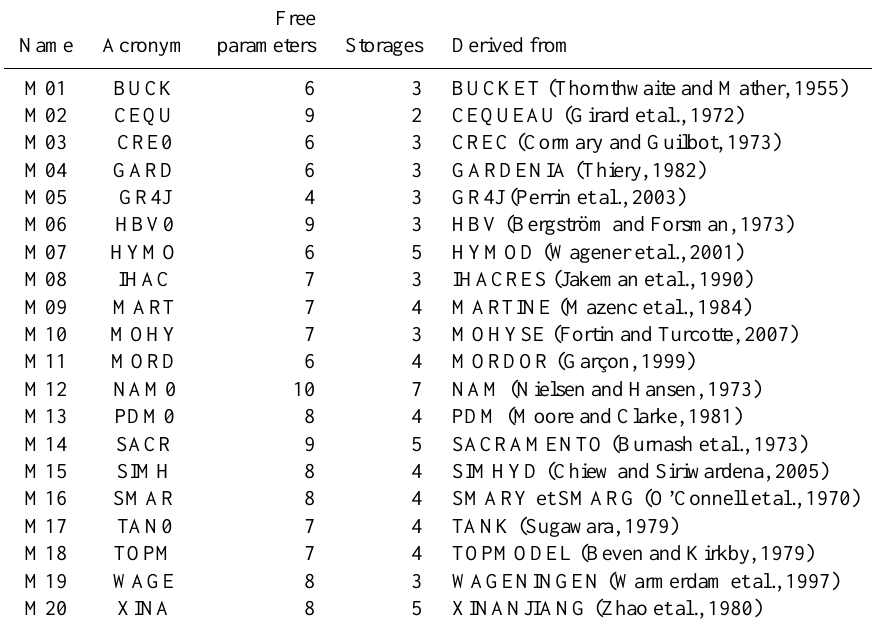
Table 1. List of the twenty lumped conceptual models and their source of inspiration.